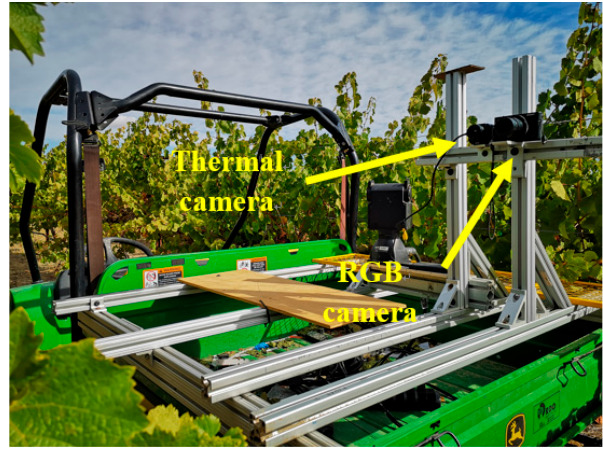
Figure 1. Thermal sensor and RGB camera mounted on a utility vehicle to acquire thermal and corresponding RGB images.